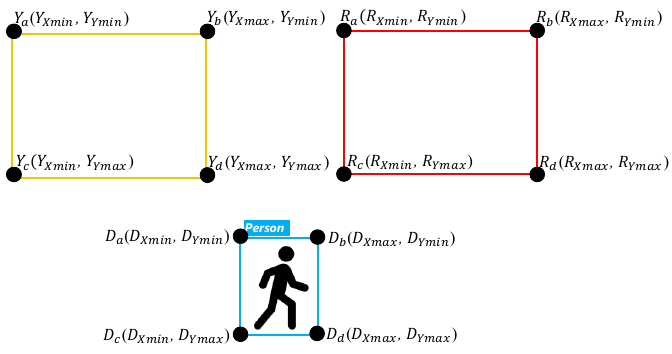
Figure 4. Rectangle detected by YOLO.